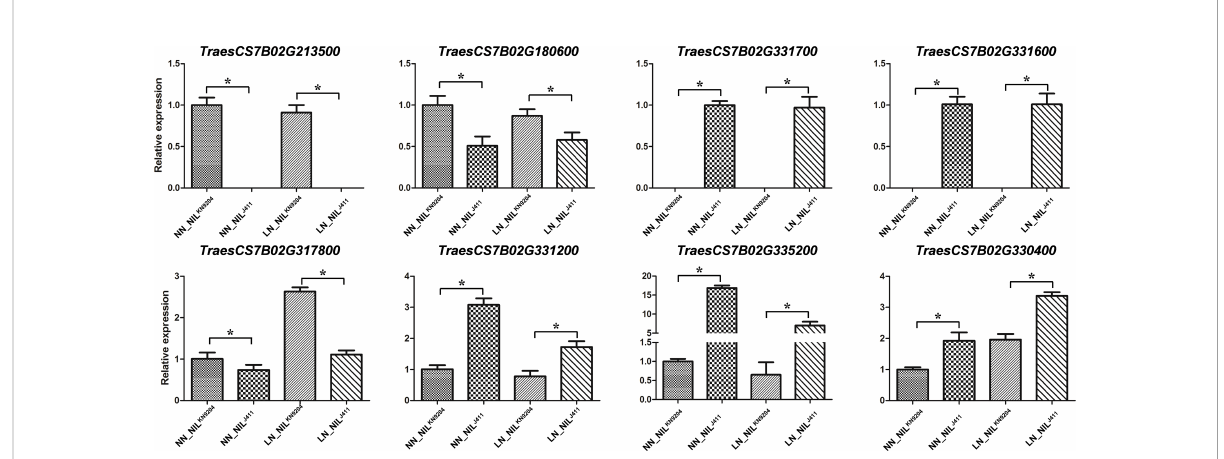
FIGURE 4 Validation of gene expression by qRT-PCR The relative mRNA expression of eight representative genes was checked by qRT-PCR. Each bar shows the mean ± standard error of three biological replicates. “ * ” indicates a signi fi cant difference at p <